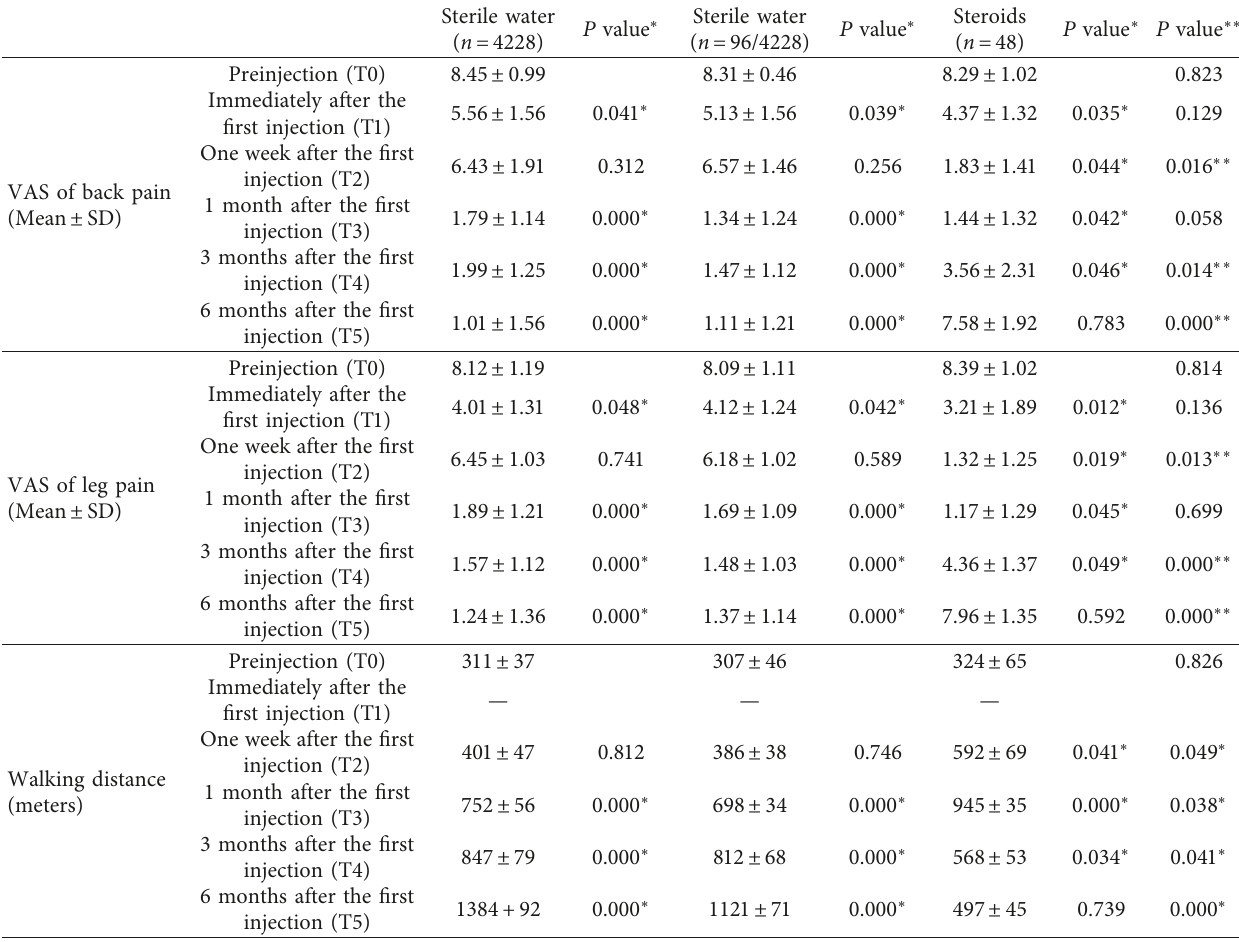
Table 2: Outcome of